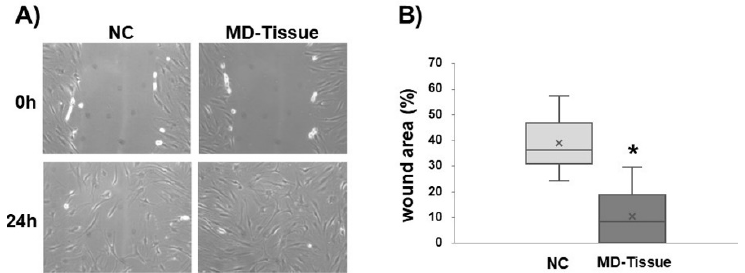
Figure 8. ( A ) Representative micrographs showing wound healing assay in control tenocytes (NC) and tenocytes grown on MD-Tissue at 0 and 24 h after the scratch. Original magnification: 10 × . ( B ) Bar graphs showing the area of wound closure, expressed as a % of the area at 0 h, in cultured tenocytes in both experimental conditions 24 h after the scratch. * p < 0.005 vs NC. ×: mean.